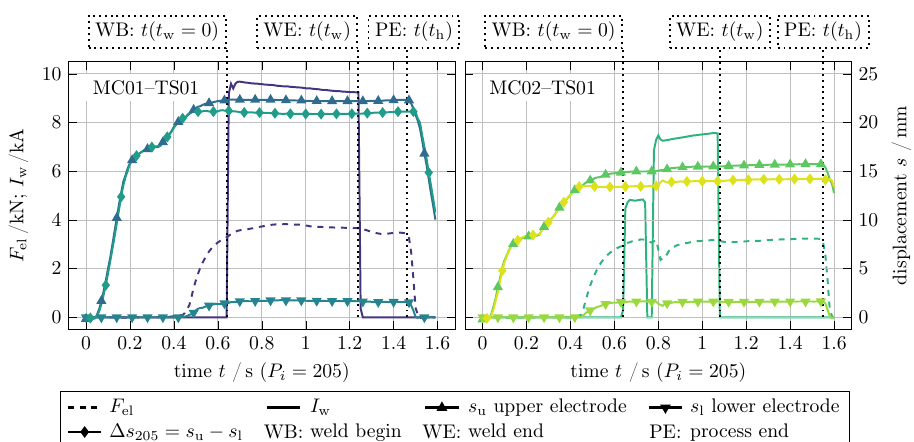
Figure 10. Exemplary process parameters of spot-weld P i = 205 of MC01–TS01 and MC02–TS01 with marked timing positions weld begin (WB), weld end (WE), and process end (PE) for further evalua- tions.